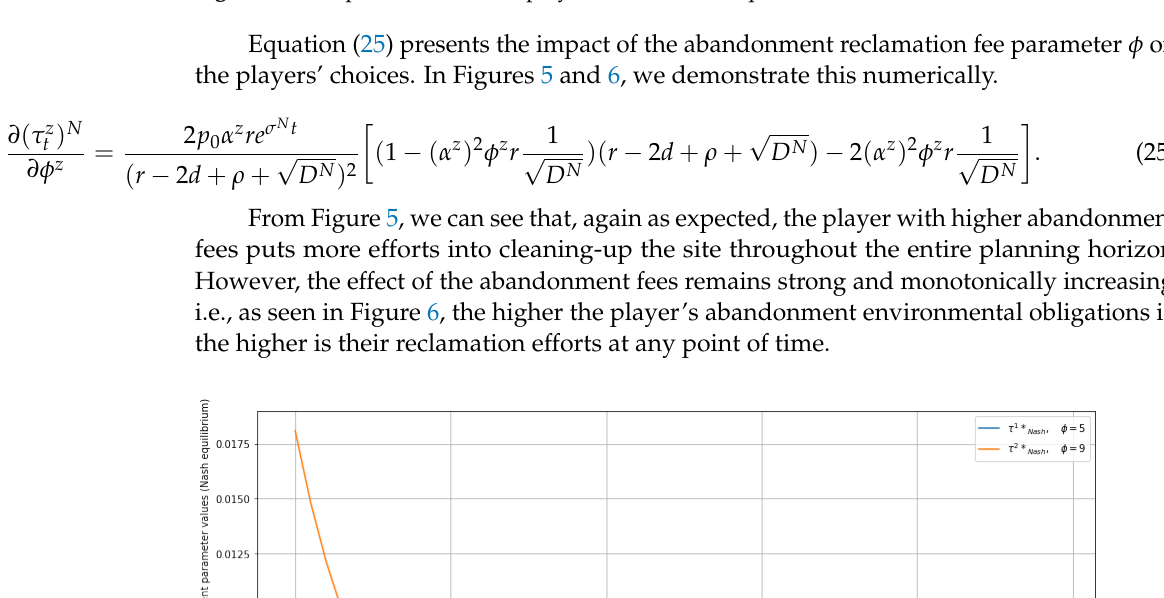
Figure 4. The optimal controls of player i under Nash equilibrium and different α .